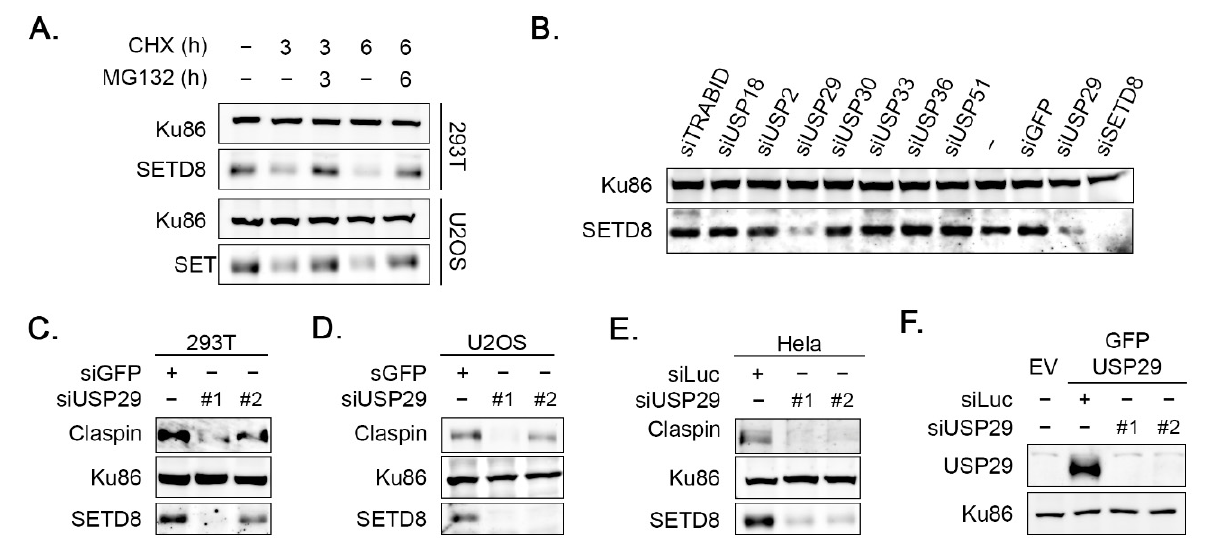
Figure 1. Depletion of USP29 affects SETD8 protein levels. ( A ) 293T cells and U2OS cells were treated with MG132 and/or CHX for 3 or 6 h. WCEs were analyzed by Western blot using the indicated antibodies. ( B ) Example of screening for ubiquitin hydrolases regulating SETD8 levels. U2OS cells were transfected with the specified siRNA oligonucleotides. Then, 48 h later, cells were lysed, and extracts were analyzed by Western blot with the indicated antibodies. ( C ) The 293T cells were transfected with GFP or the indicated USP29 siRNA oligonucleotides, lysed, and subsequently analyzed by Western blot using the indicated antibodies. ( D ) As in ( C ), but in U2OS cells. ( E ) HeLa cells were transfected with Luciferase (Luc) or the indicated USP29 siRNA oligonucleotides. WCEs were analyzed by Western blot using the indicated antibodies. ( F ) U2OS cells were transfected with an empty vector (EV) or GFP-USP29 and thereafter transfected with Luc or USP29 siRNA oligonucleotides. Extracts were analyzed by Western blot analysis with the indicated antibodies.